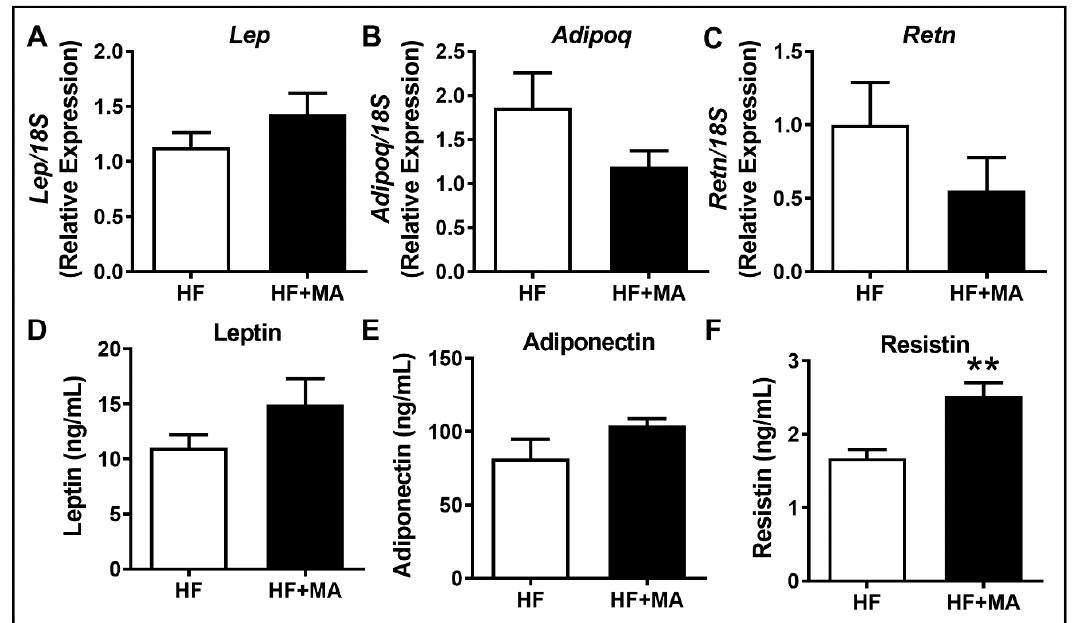
Figure 6. Effect of dietary myristic acid on adipokines. Real-time PCR analysis was performed in the VAT for the mRNA levels of Lep , Adipoq , and Retn , encoding leptin, adiponectin, and resistin, respectively ( A – C ). Plasma levels of these adipokines were determined by multiplex analysis ( D – F ). Values are expressed as mean ± SEM of 7–8 samples in each group. ** p < 0.01 vs. HF. HF, high fat; HF+MA, high fat + myristic